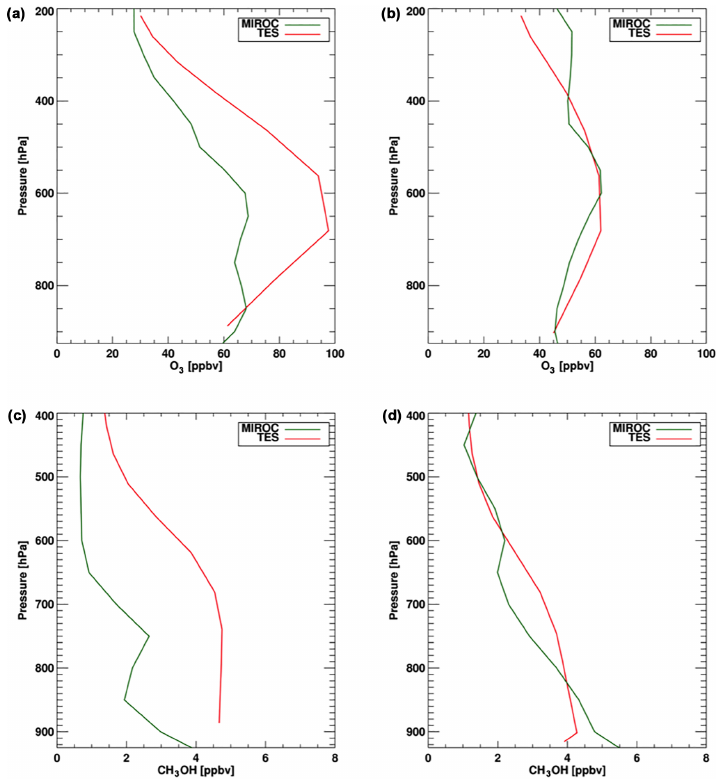
Figure 8. MIROC model and TES retrieved profiles for O 3 (a, b) and CH 3 OH (b, c) on 9 May (a, c) and 25 May (b, d) .